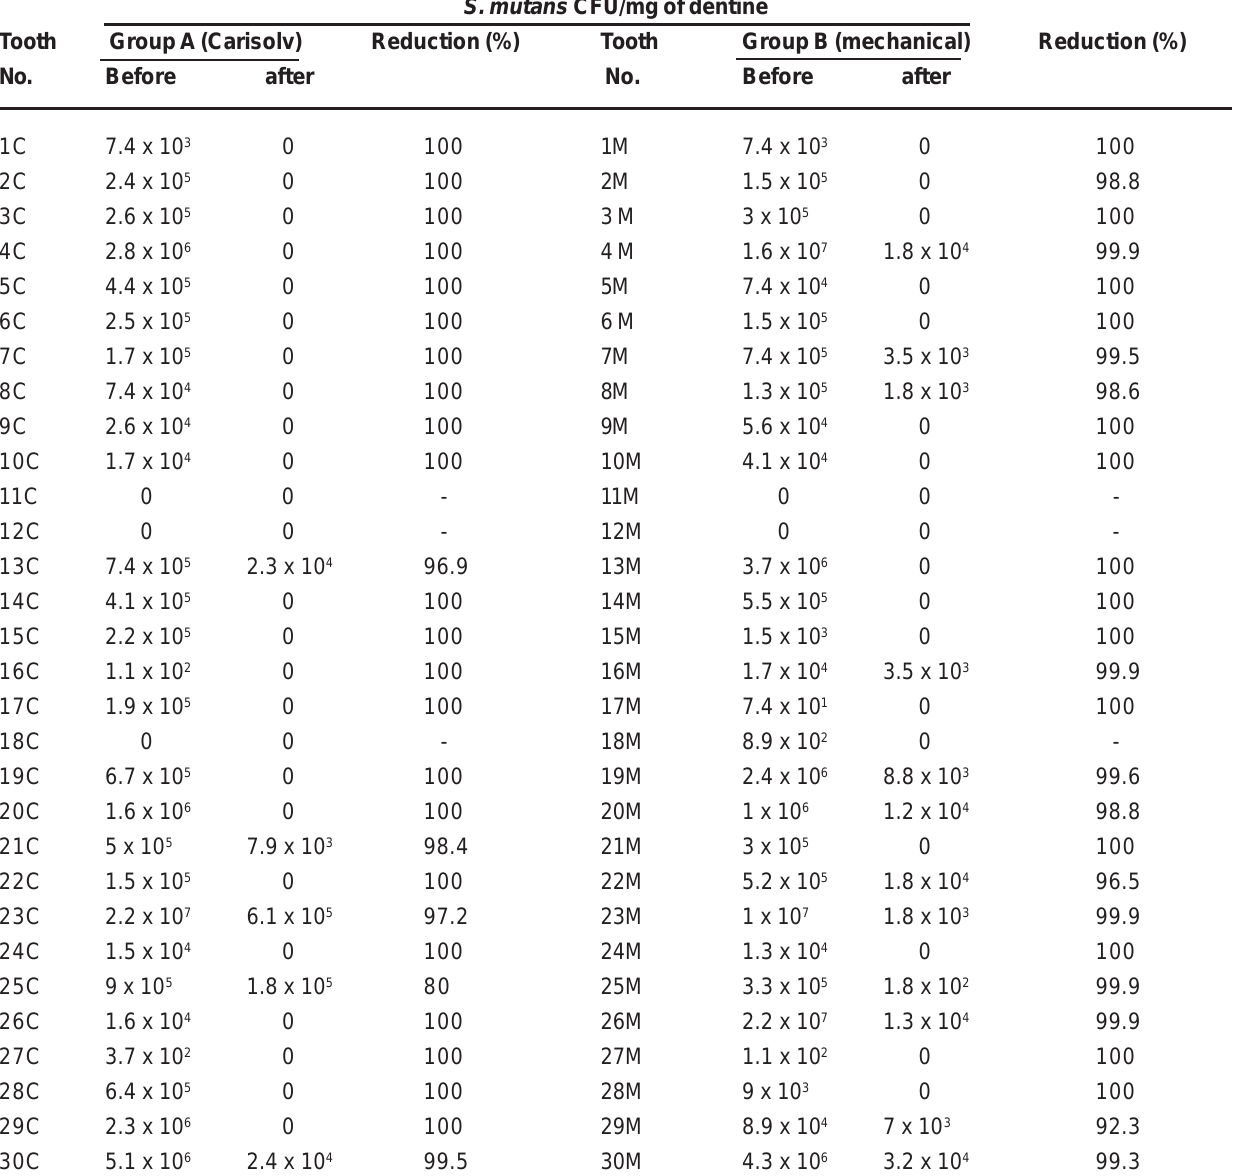
TABLE 2 - S. mutans counts before and after treatment of carious dentine of primary molars with Carisolv TM and the mechanical